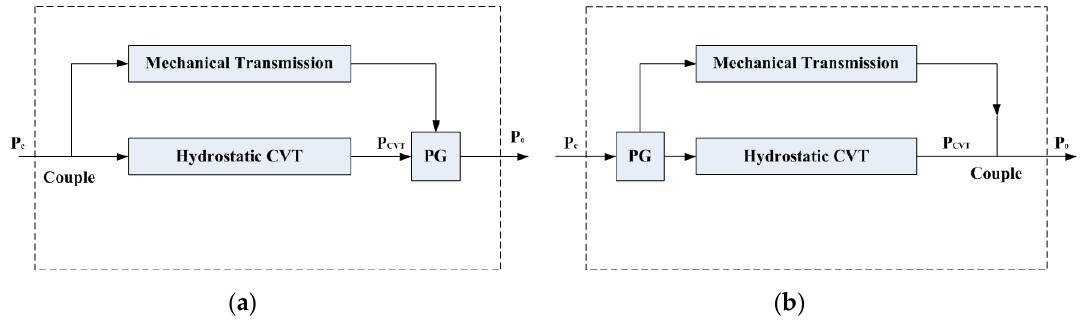
Figure 3. Types of the HMCVT. ( a ) Input coupling type; ( b ) Output coupling type.